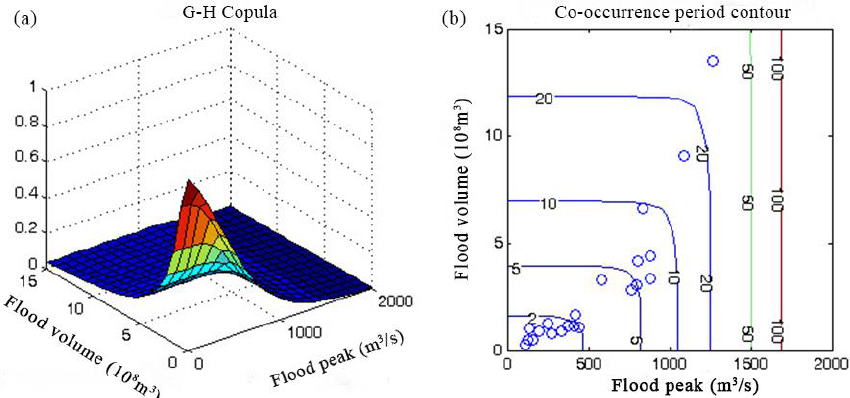
Figure 6. ( a ) Peak-volume co-occurrence distribution; ( b ) The contour of Peak-volume co-occurrence period.